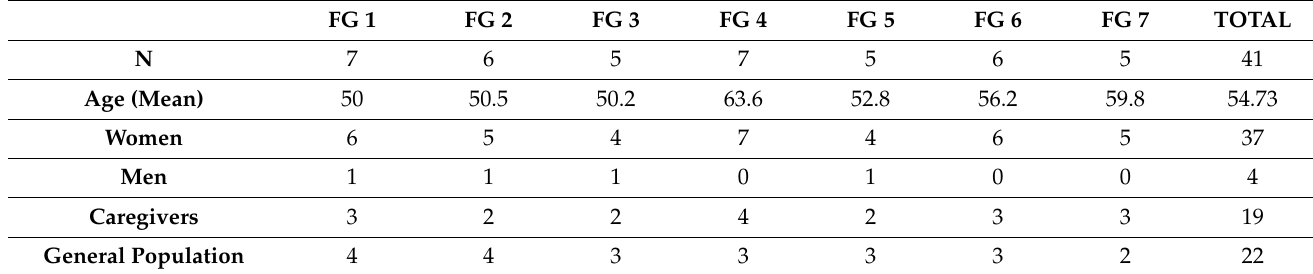
Table 1. Sociodemographic characteristics of the focus groups